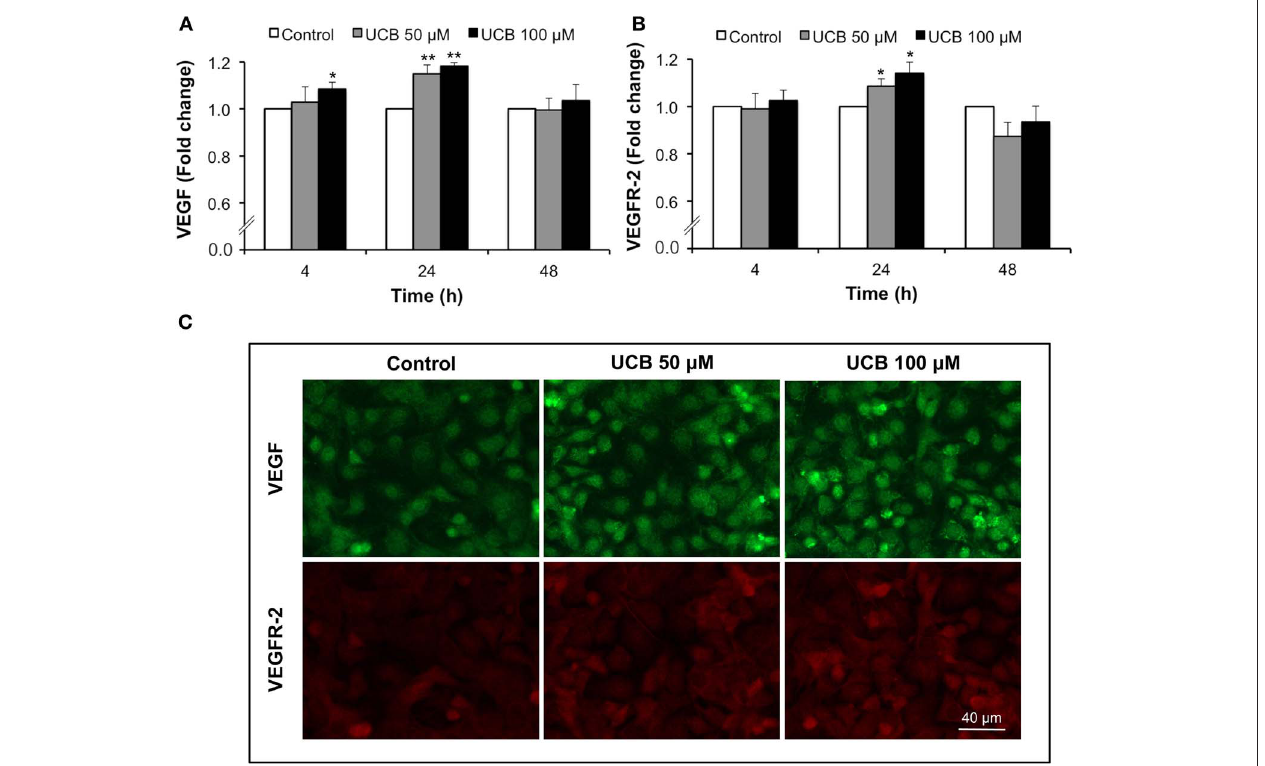
of fluorescence intensity per number of cells. Quantification of VEGF (A) and VEGFR-2 (B) levels is indicated as fold change from respective control. Representative results of the 24h period of incubation are shown (C) . Results are means ± SEM from at least five independent experiments performed in duplicate. ∗ P < 0 . 05 and ∗∗ P < 0 . 01 vs . respective